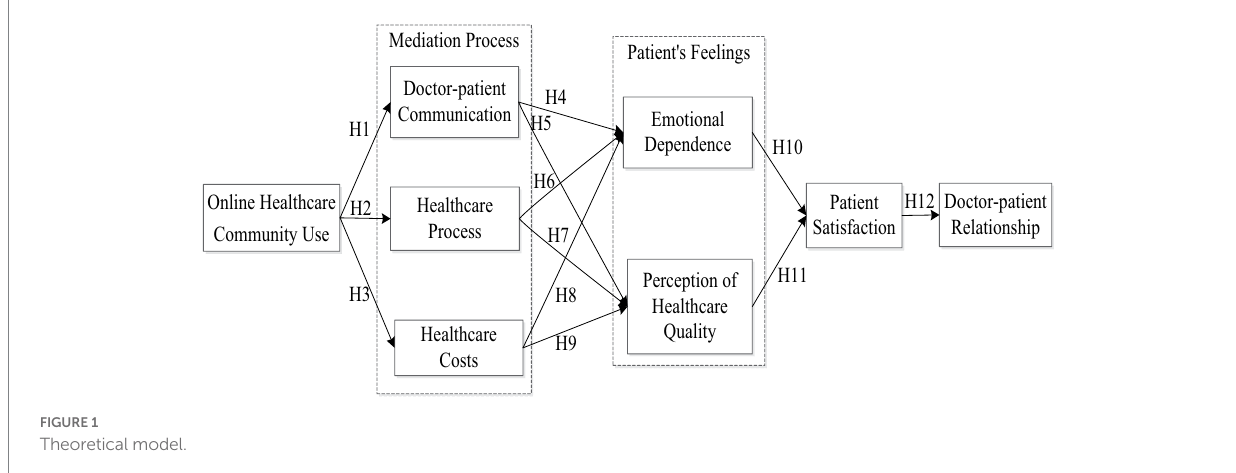
FIGURE 1 Theoretical